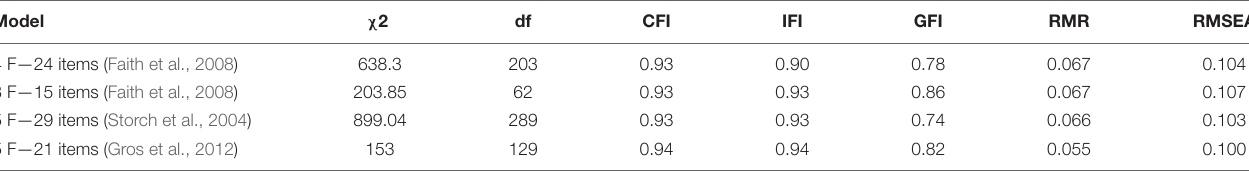
TABLE 2 | The goodness of fit indices for all CFA models of TQ-R.